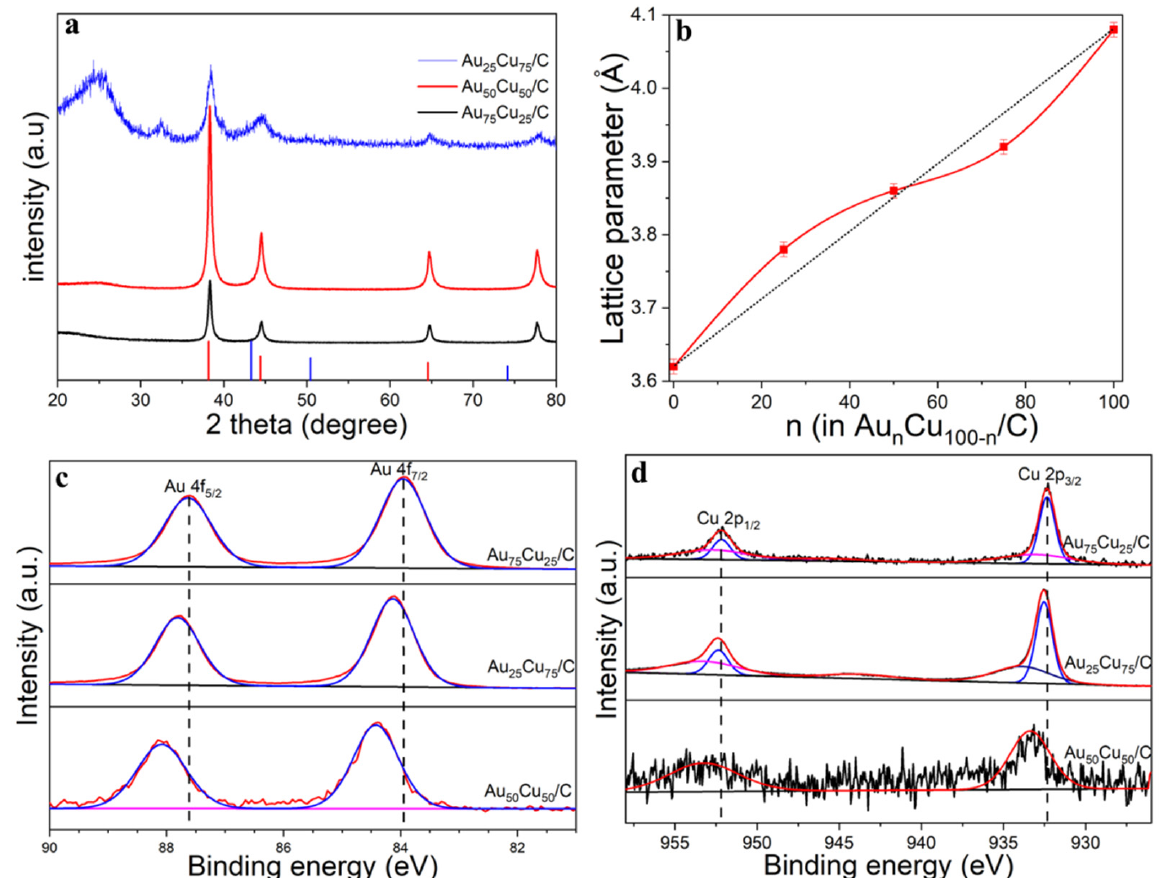
Figure 2. ( a ) XRD patterns of Au 25 Cu 75 /C, Au 50 Cu 50 /C and Au 75 Cu 25 /C. ( b ) Dependence of the lattice parameters for the Au n Cu 100 − n NPs samples on the relative composition of Au%. ( c ) Au 4f XPS spectra of Au 25 Cu 75 /C, Au 50 Cu 50 /C and Au 75 Cu 25 /C. ( d ) Cu 2p XPS spectra of Au 25 Cu 75 /C, Au 50 Cu 50 /C and Au 75 Cu 25 /C.